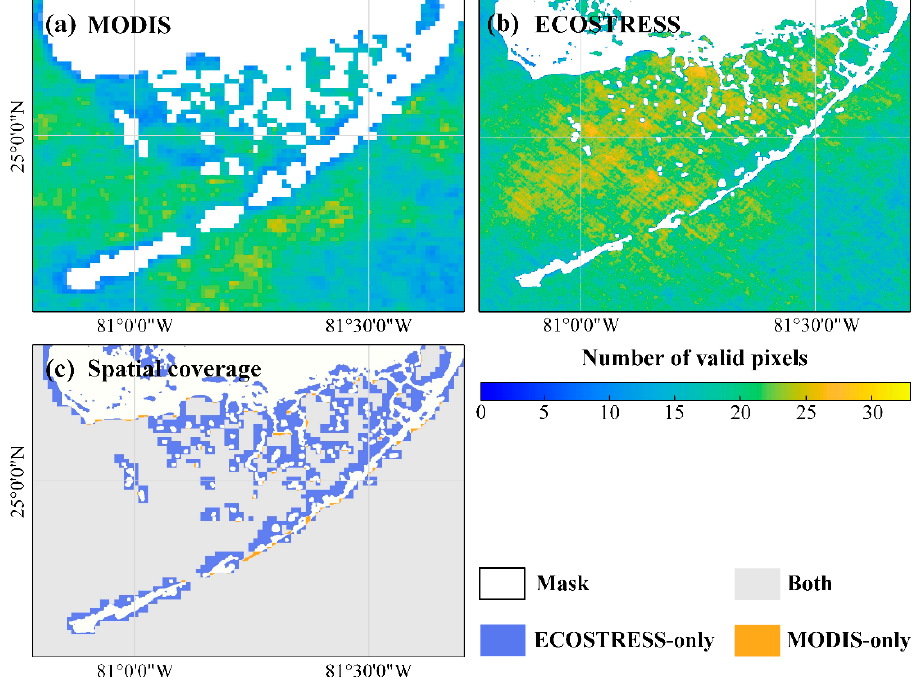
Figure 8. Number of valid pixels from 33 concurrent image pairs of ( a ) MODIS and ( b ) ECOSTRESS from August 2018 to August 2020. Note the resolution difference between MODIS (1 km) and ECOSTRESS (70 m); ( c ) Spatial coverage of the 33 concurrent MODIS and ECOSTRESS images between August 2018 and August 2020. White color represents land and masked pixels, and gray color indicates valid pixels from both ECOSTRESS and MODIS.